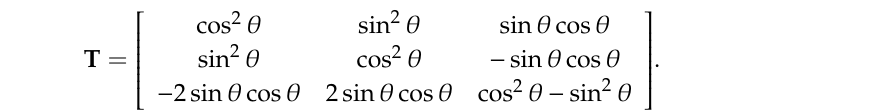
Table 1. Laminate ply Thickness.